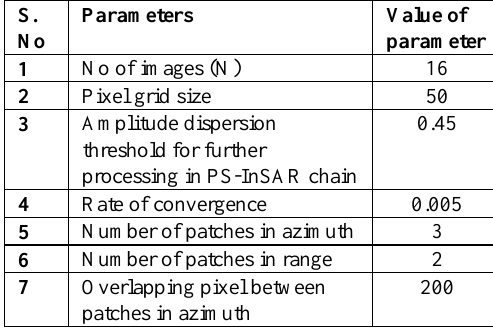
Table 2. Parameters for PS-InSAR processing of Tehri